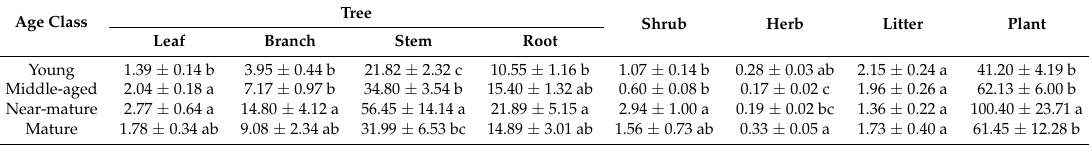
Table 5. Carbon storage allocation of Quercus variabilis natural forests (Mg · ha − 1 ).